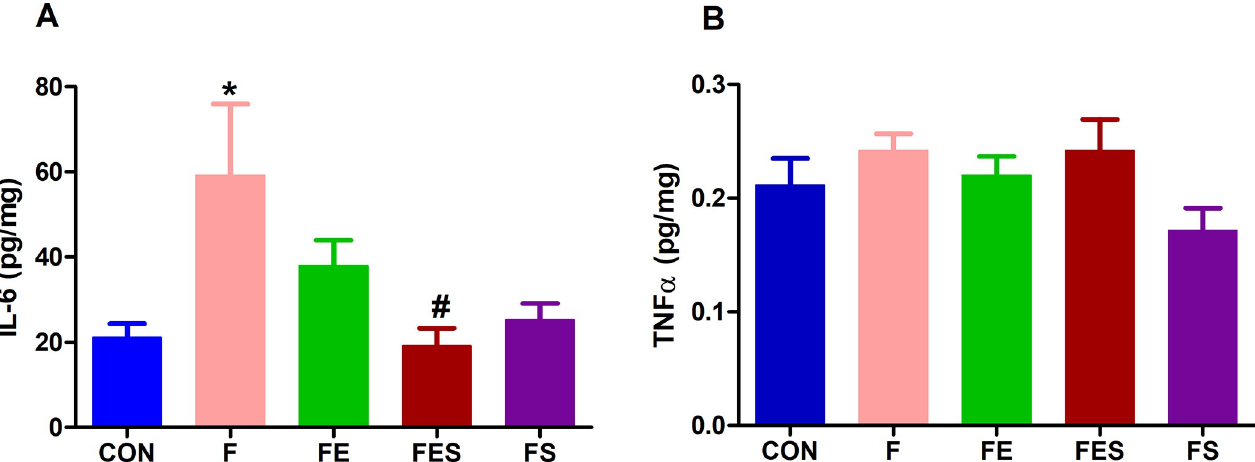
Fig 3. Concentrations of inflammatory cytokines in muscle tissue. (A) Interleukin-6 (IL-6). (B) Tumor necrosis factor (TNF). CON, control; F, fibromyalgia induced; FE, fibromyalgia induced plus exercise; FES, fibromyalgia induced plus exercise and TRP supplementation; FS, fibromyalgia induced plus TRP supplementation. Data are means ± SD from 6 to 8 animals in each group). � p < 0.05 vs CON group. # p < 0.05 vs F group (ANOVA one-way followed by Tukey’s post hoc test).